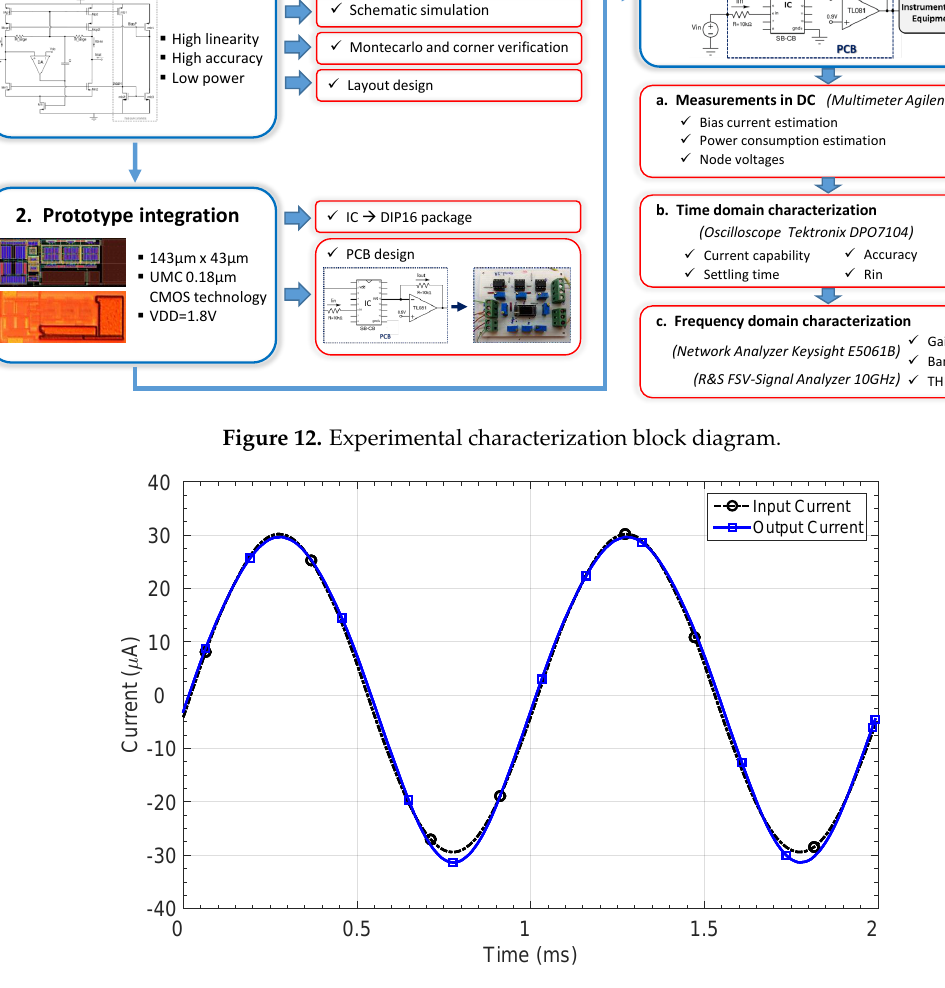
Figure 13. Integrated current buffer SB-CB2 measurement in the time domain.